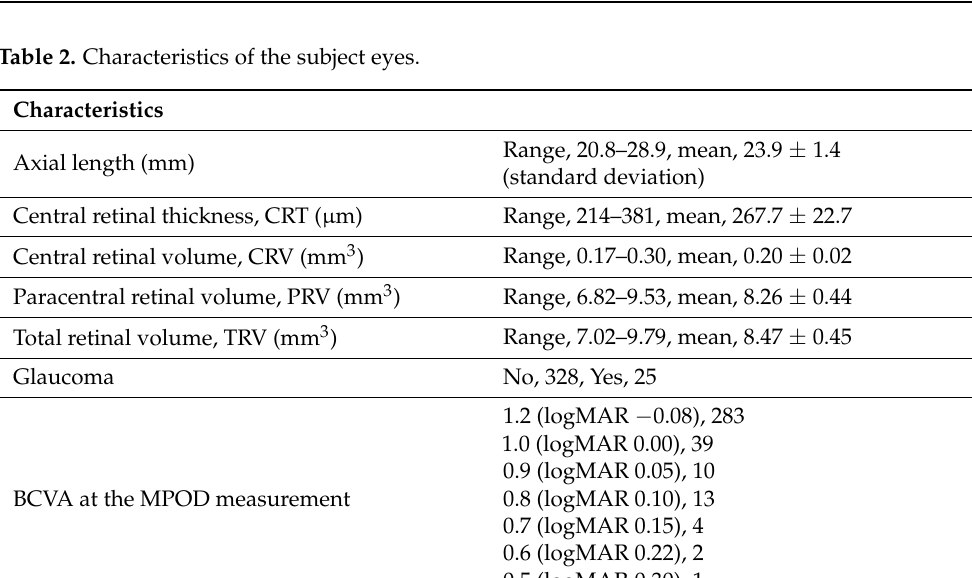
Table 2. Characteristics of the subject